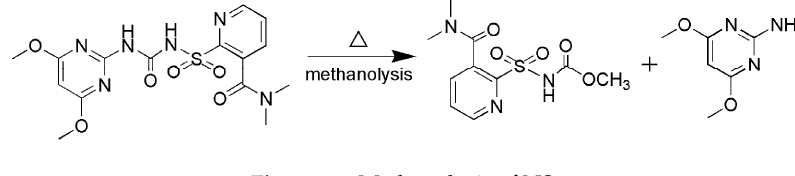
Figure 12. Methanolysis of NS.